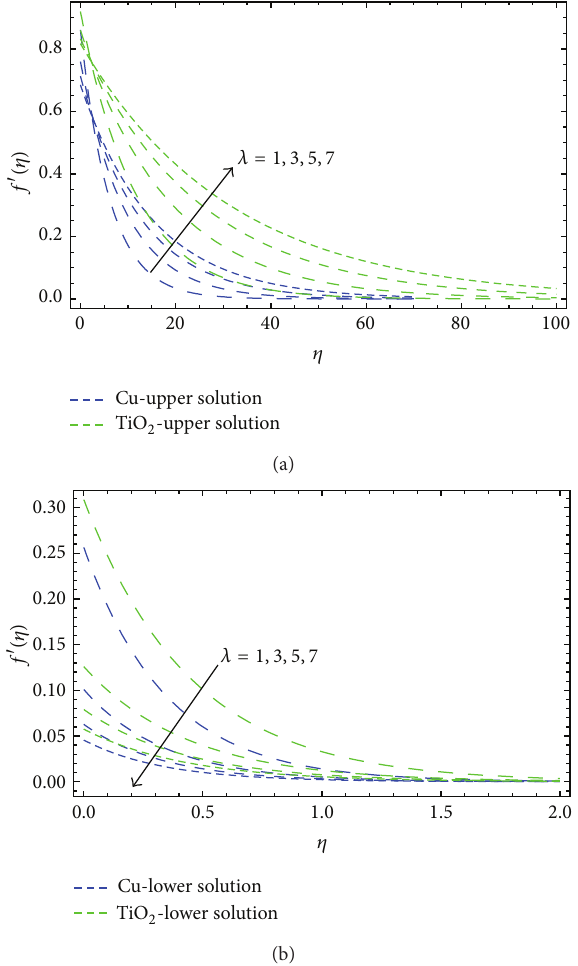
Figure 14: (a) Upper velocity solutions for several values of 𝜆 for the Cu-water and the TiO 2 -water nanofluids at 𝑠 = 2 , 𝜙 = 0.1 , and 𝑀 = 1 .(b)Lowervelocitysolutionsforseveralvaluesof 𝜆 fortheCu- water and the TiO 2 -water nanofluids at 𝑠 = 2 , 𝜙 = 0.1 , and 𝑀 = 1